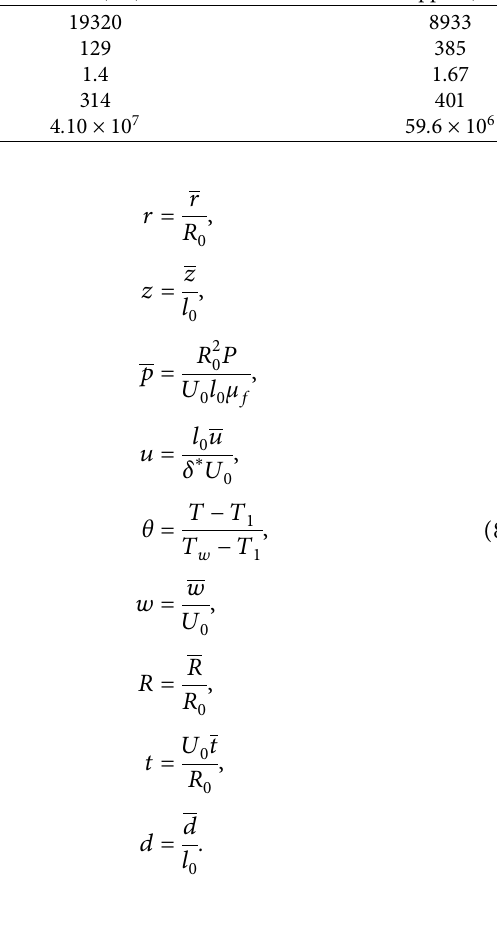
Figure 1: Physical configuration of the problem. Table 1: Values of the various physical parameters (blood, gold and copper) (Das et al. [7], Koriko [39], and Kumar and Srinivas [40]). Physical